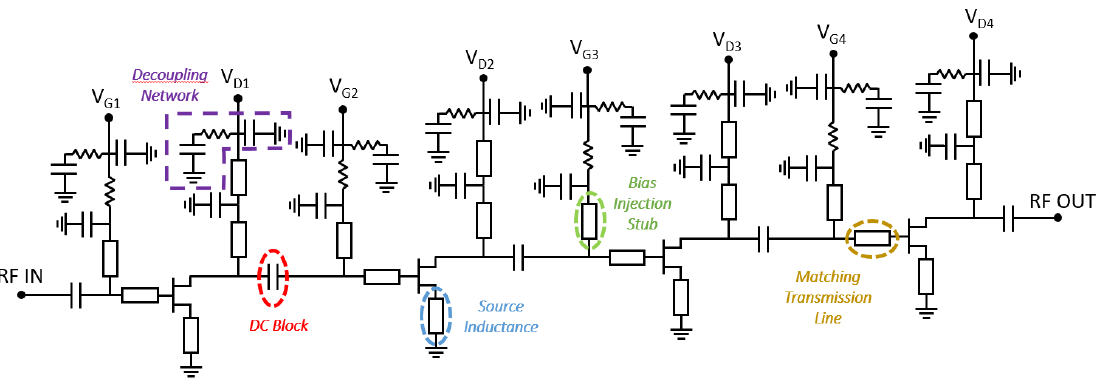
Figure 6. Simplified circuit scheme of the designed LNA.